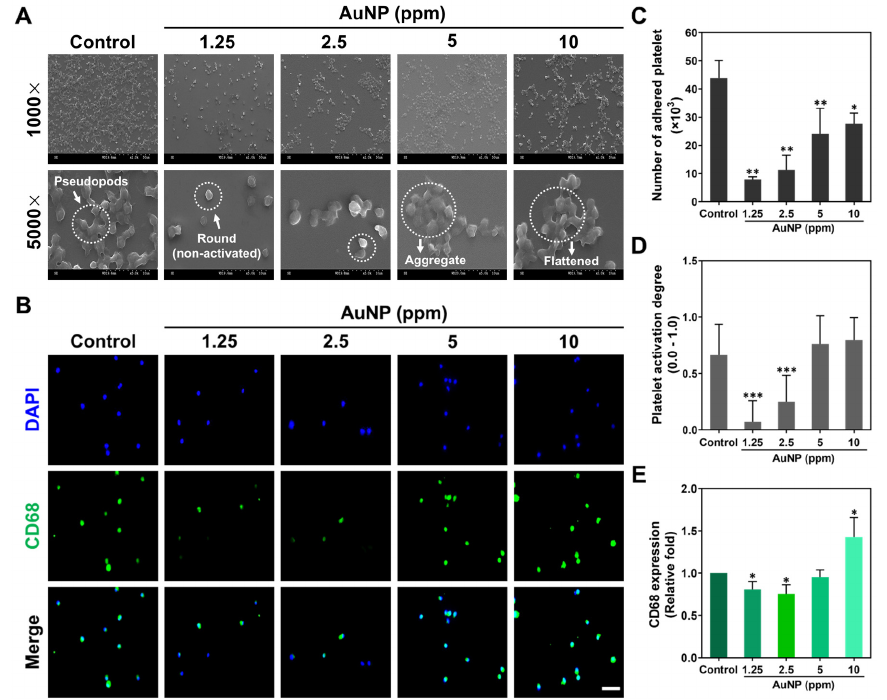
Figure 3. Activation of platelet cells and monocytes after AuNP treatments. ( A ) The morphology of platelets after 24 h of AuNP treatments was explored via SEM. The white arrow in the Control group is represented as pseudopods morphology. The round shape in the 1.25 ppm AuNP group indicates a non-activated form, while the white arrow in the 5 ppm AuNP treatment indicates an aggregated state. ( B ) A CD68 macrophage marker expressed in monocytes is demonstrated using the IF staining method after 96 h of treatment. Blue fluorescence is the cell nuclei located by a DAPI solution, while green fluorescence indicates the expression of CD68. Scale bar = 20 μ m. ( C,D ) The adhered number and activation degree of platelet cells were quantified for each treatment. The results elucidate that the 1.25 and 2.5 ppm AuNP groups had the lower platelets adhered amount and activation degree. ( E ) The fluorescence intensity of CD68 expression was semi-quantified, which demonstrated the lower expression in both 1.25 and 2.5 ppm AuNP treatments. Scale bar = 50 μ m. The above results are represented as mean ± SD ( n = 3). * p < 0.05, ** p < 0.01, *** p < 0.001: compared to the Control group (TCPS).